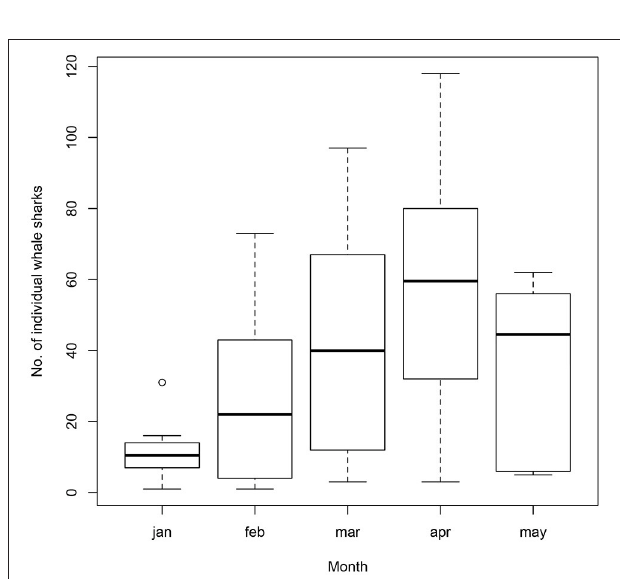
whale sharks to Donsol over